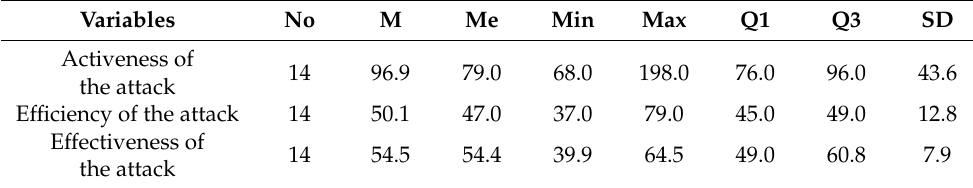
Table 3. Value of activeness, efficiency, and effectiveness of the